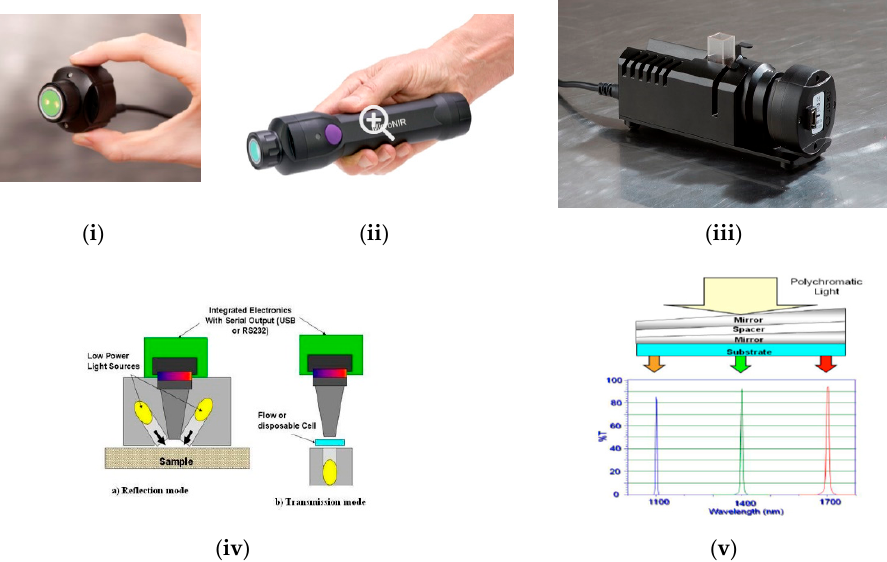
Figure 3. The handheld MicroNIR spectrometer. ( i ) and ( ii ) The MicroNIR 1700 spectrometer with and without a holder; ( iii ) The MicroNIR Pro and the transmission fixtures; ( iv ) Optical design of MicroNIR working in diffuse reflection and transmission modes; ( v ) Working principle of a linear variable filter (LVF) component. (The images are originally from [50–52], copyright permission has been granted).